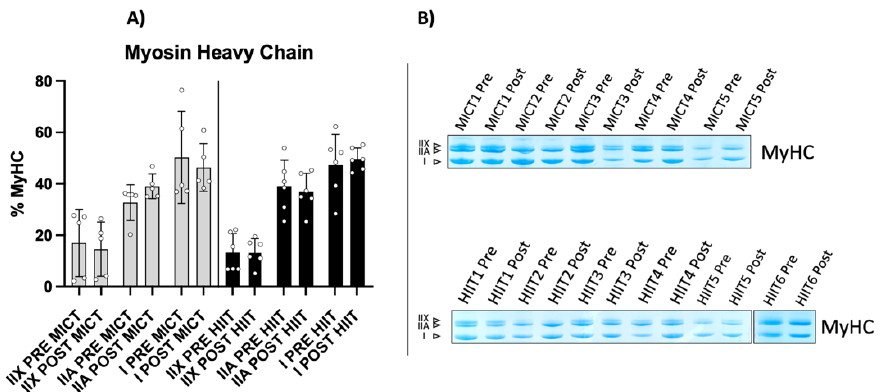
Figure 3. Myosin heavy chain isoform distribution. ( A ) Histogram showing myosin heavy chain isoform distribution for each human isoform, in MICT and HIIT, respectively. ( B ) Representative 8% acrylamide/bis ‐ acrylamide gel obtained from both training groups. MyHC results are derived from two separate gels as shown in the figure.